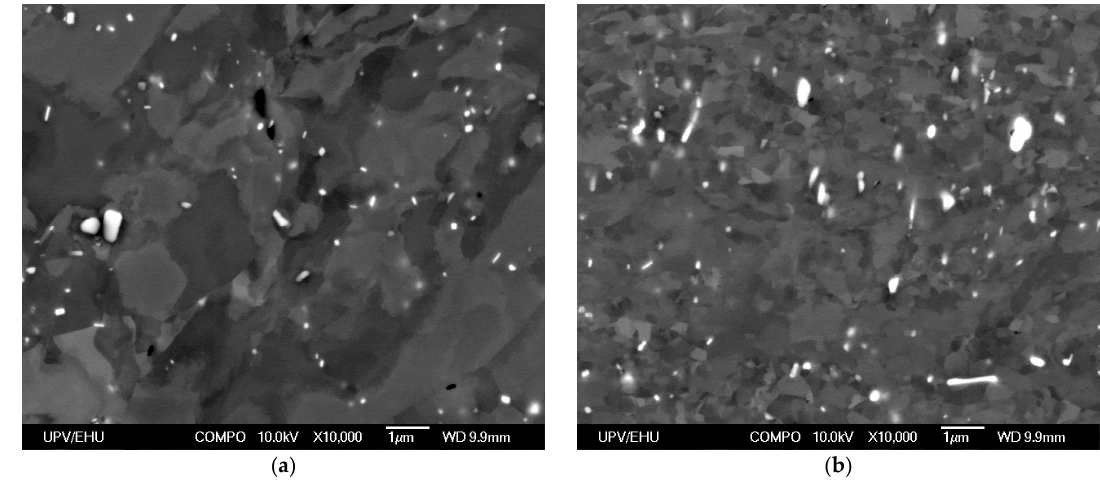
Figure 4. Scanning electron microscopy (SEM) micrographs of different isothermally ‐ forged AA ‐ 5083 states: ( a ) AA ‐ 5083 at N0 (annealed); ( b ) AA ‐ 5083 at N2 (equal channel angular pressing (ECAP) ‐ processed). Taken from the research work by León et al. [23].